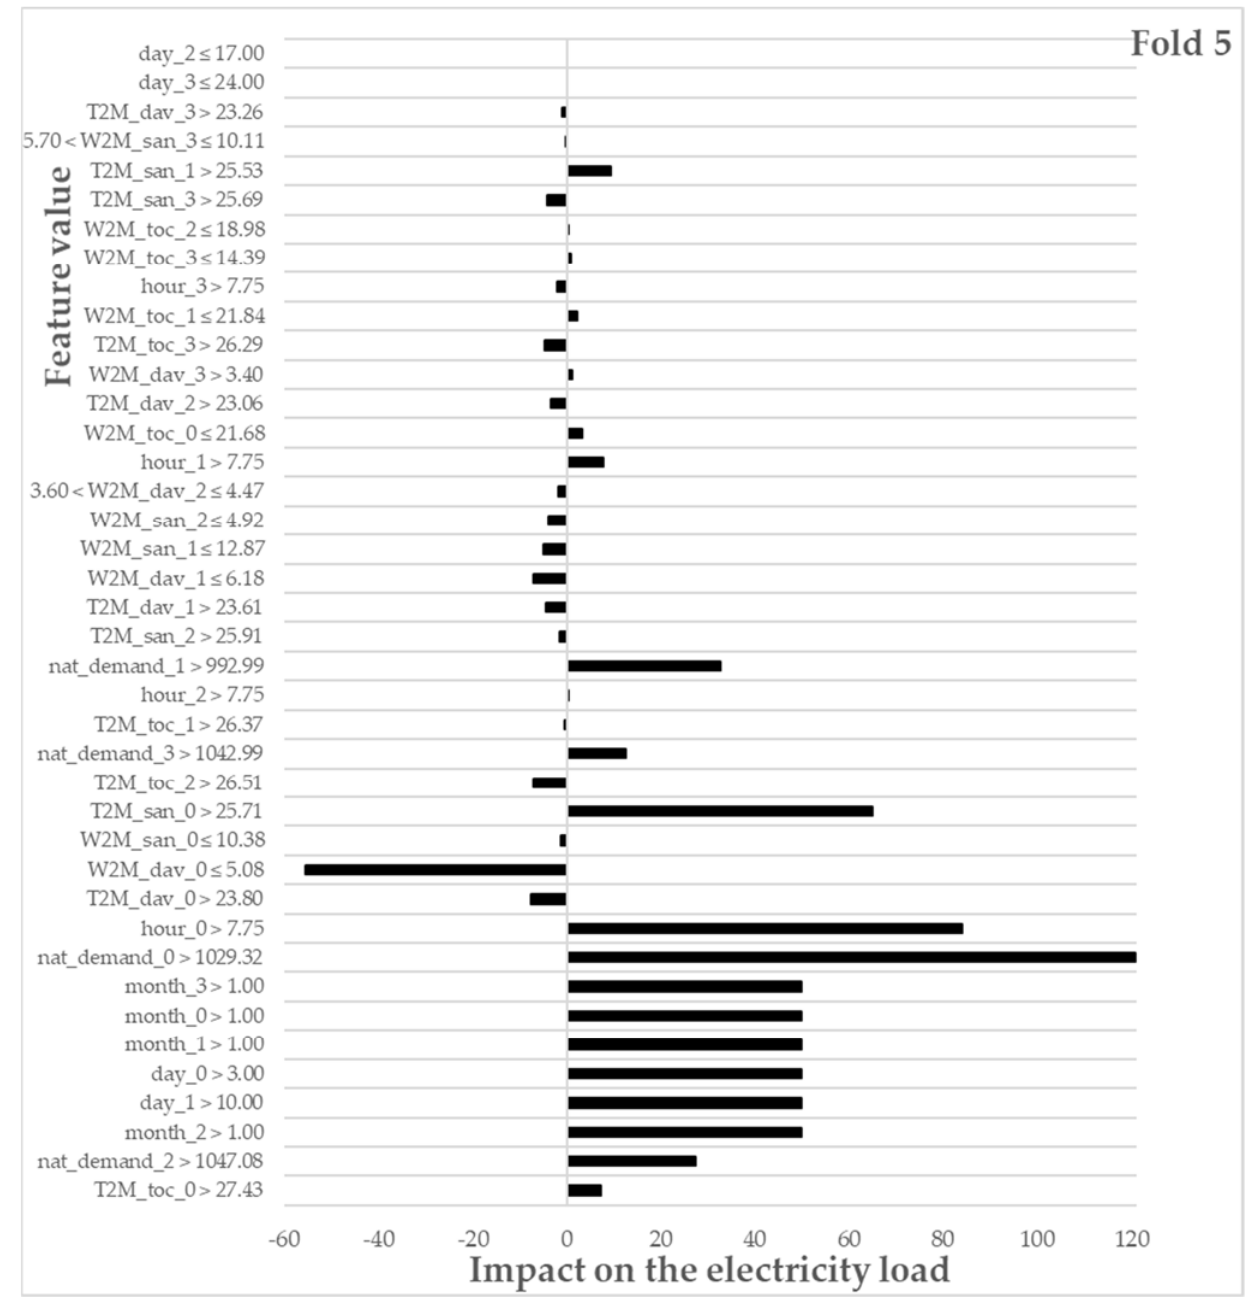
Figure A2. Explanations provided by LIME for LSTM and Fold 2–5 (experiment 2).